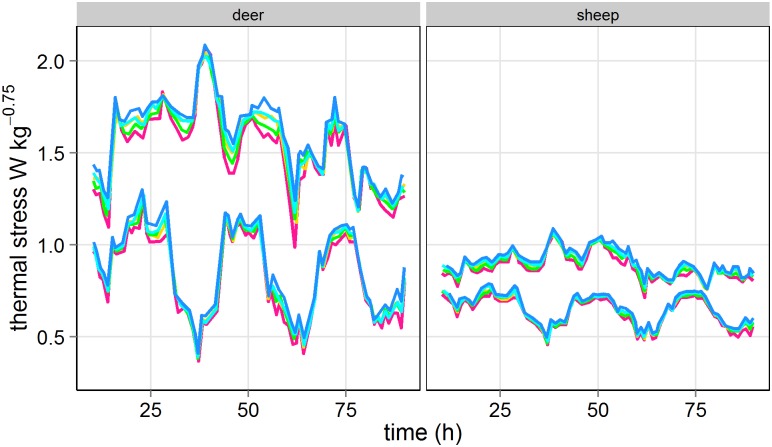
Winter and summer thermal stress in different vegetation types (bracken: pink; dry heath: yellow; grass: green, rushes: light blue; wet heath: blue, in deer (a) and sheep (b) across a sample of 90 consecutive hours within season.The group of lines with higher values within species is the winter season.